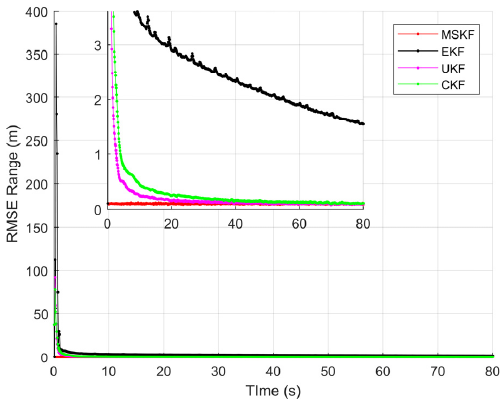
Figure 8. Range estimation accuracy of CL distribution.